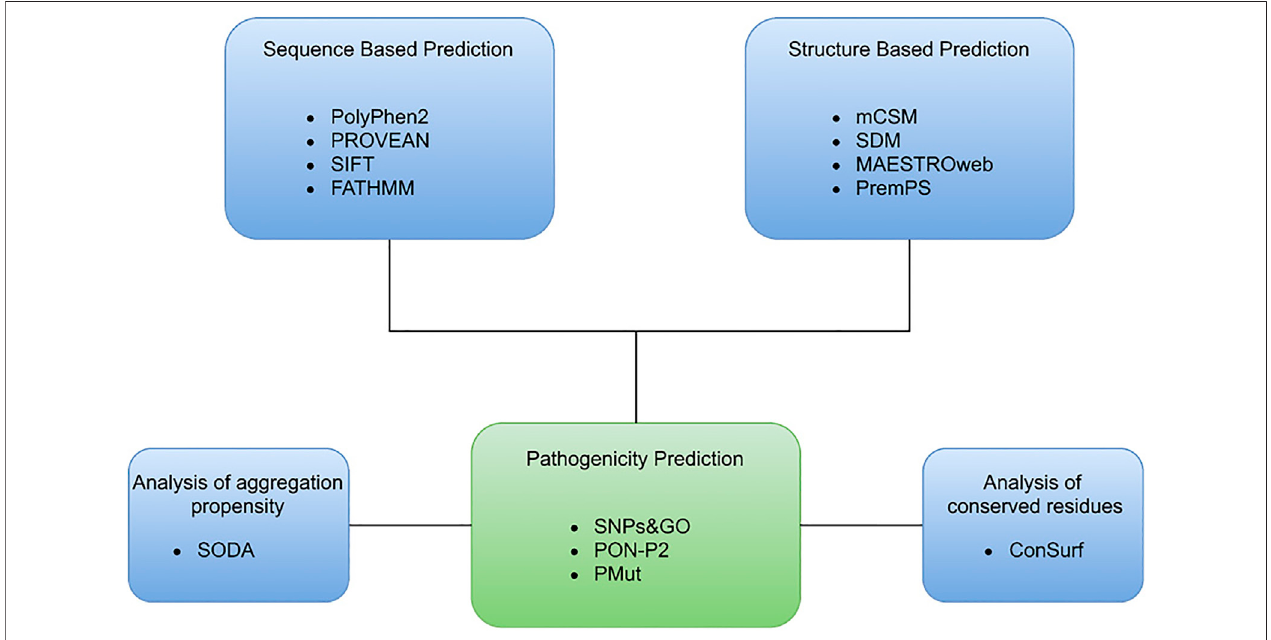
FIGURE 2 | Overview of representation of the computational approach used to identify the deleterious mutations in SGK1.